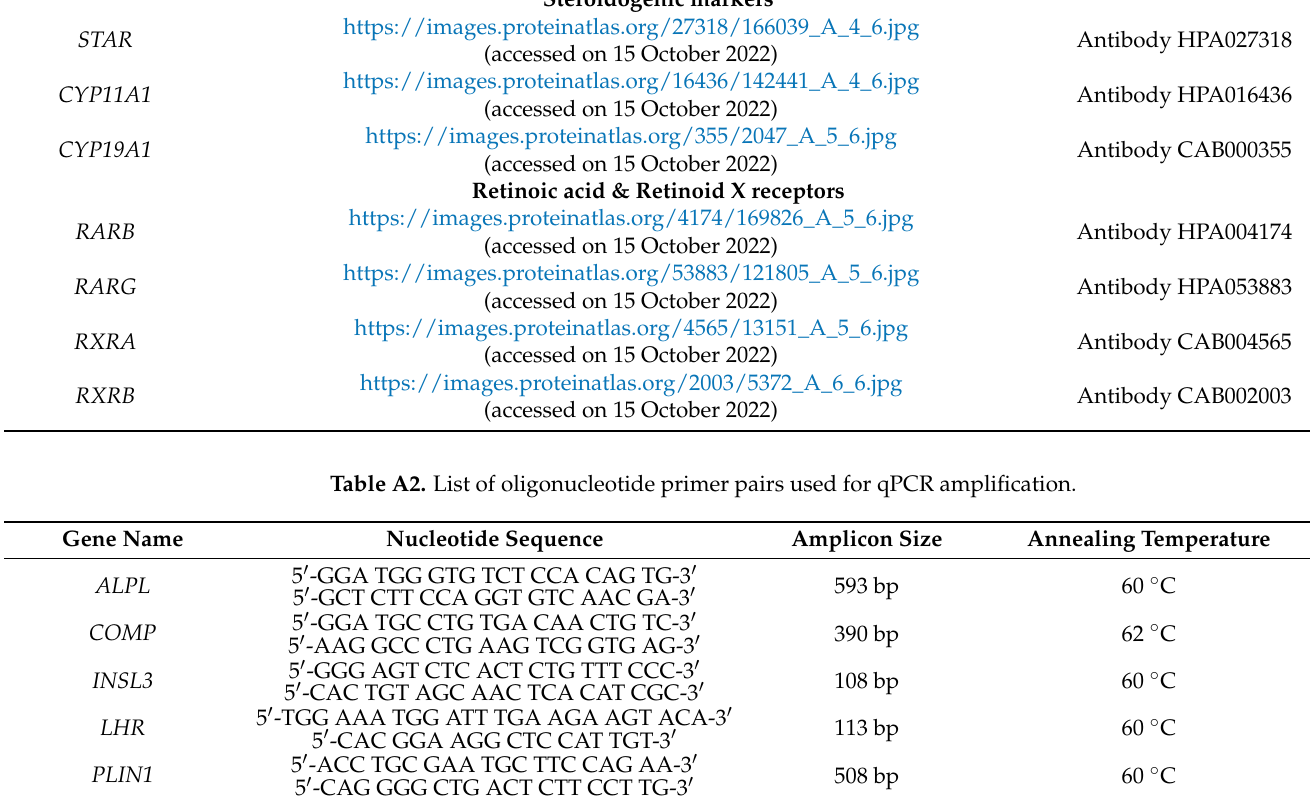
√ when in brackets, indicates